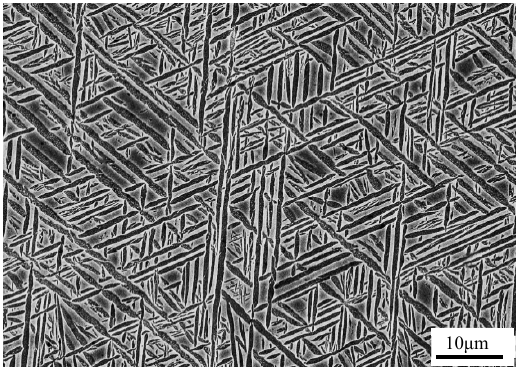
Figure 1. Original micrograph of Ti17 alloy.